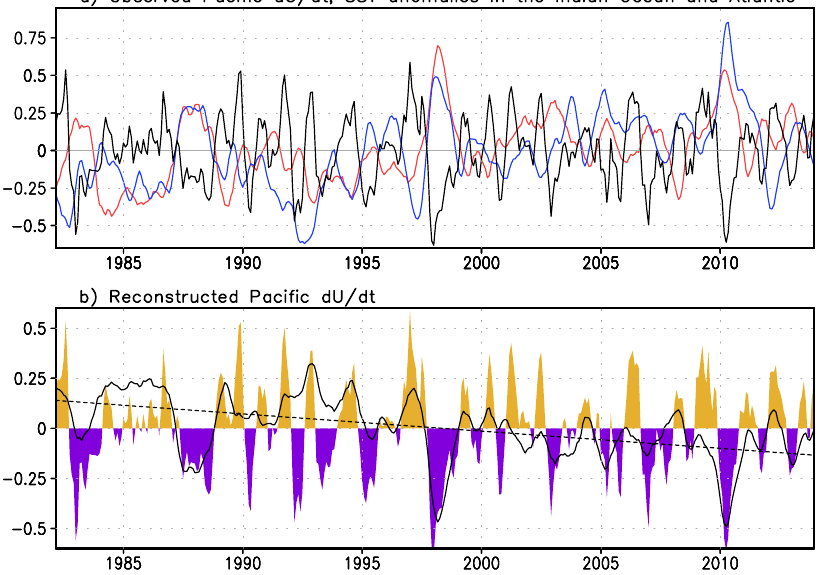
Figure 3. Observed and reconstructed zonal wind anomaly tendency in the central Pacific Ocean. ( a ) The observed zonal wind anomaly tendency in the central Pacific Ocean (dU/dt, black line), the SST anomalies in the tropical Indian Ocean (red line, 20°S–20°N, 40°E–120°E) and Atlantic Ocean (blue line, 20°S–20°N, 70°W–15°E). Results are based on 5-month running mean anomalies. ( b ) The observed dU/dt (colour filled line) and reconstructed dU/dt (black solid line, with the linear trend being included) in the central Pacific Ocean based on the SST anomalies in the Indian Ocean and Atlantic Ocean (see Methods). The black dashed line denotes the linear trend component of the reconstructed dU/dt that displays an easterly tendency trend forced by the rapid SST warming in the Indian Ocean and Atlantic Ocean. This figure is created using Grid Analysis and Display System (GrADS) Version 2.0.2